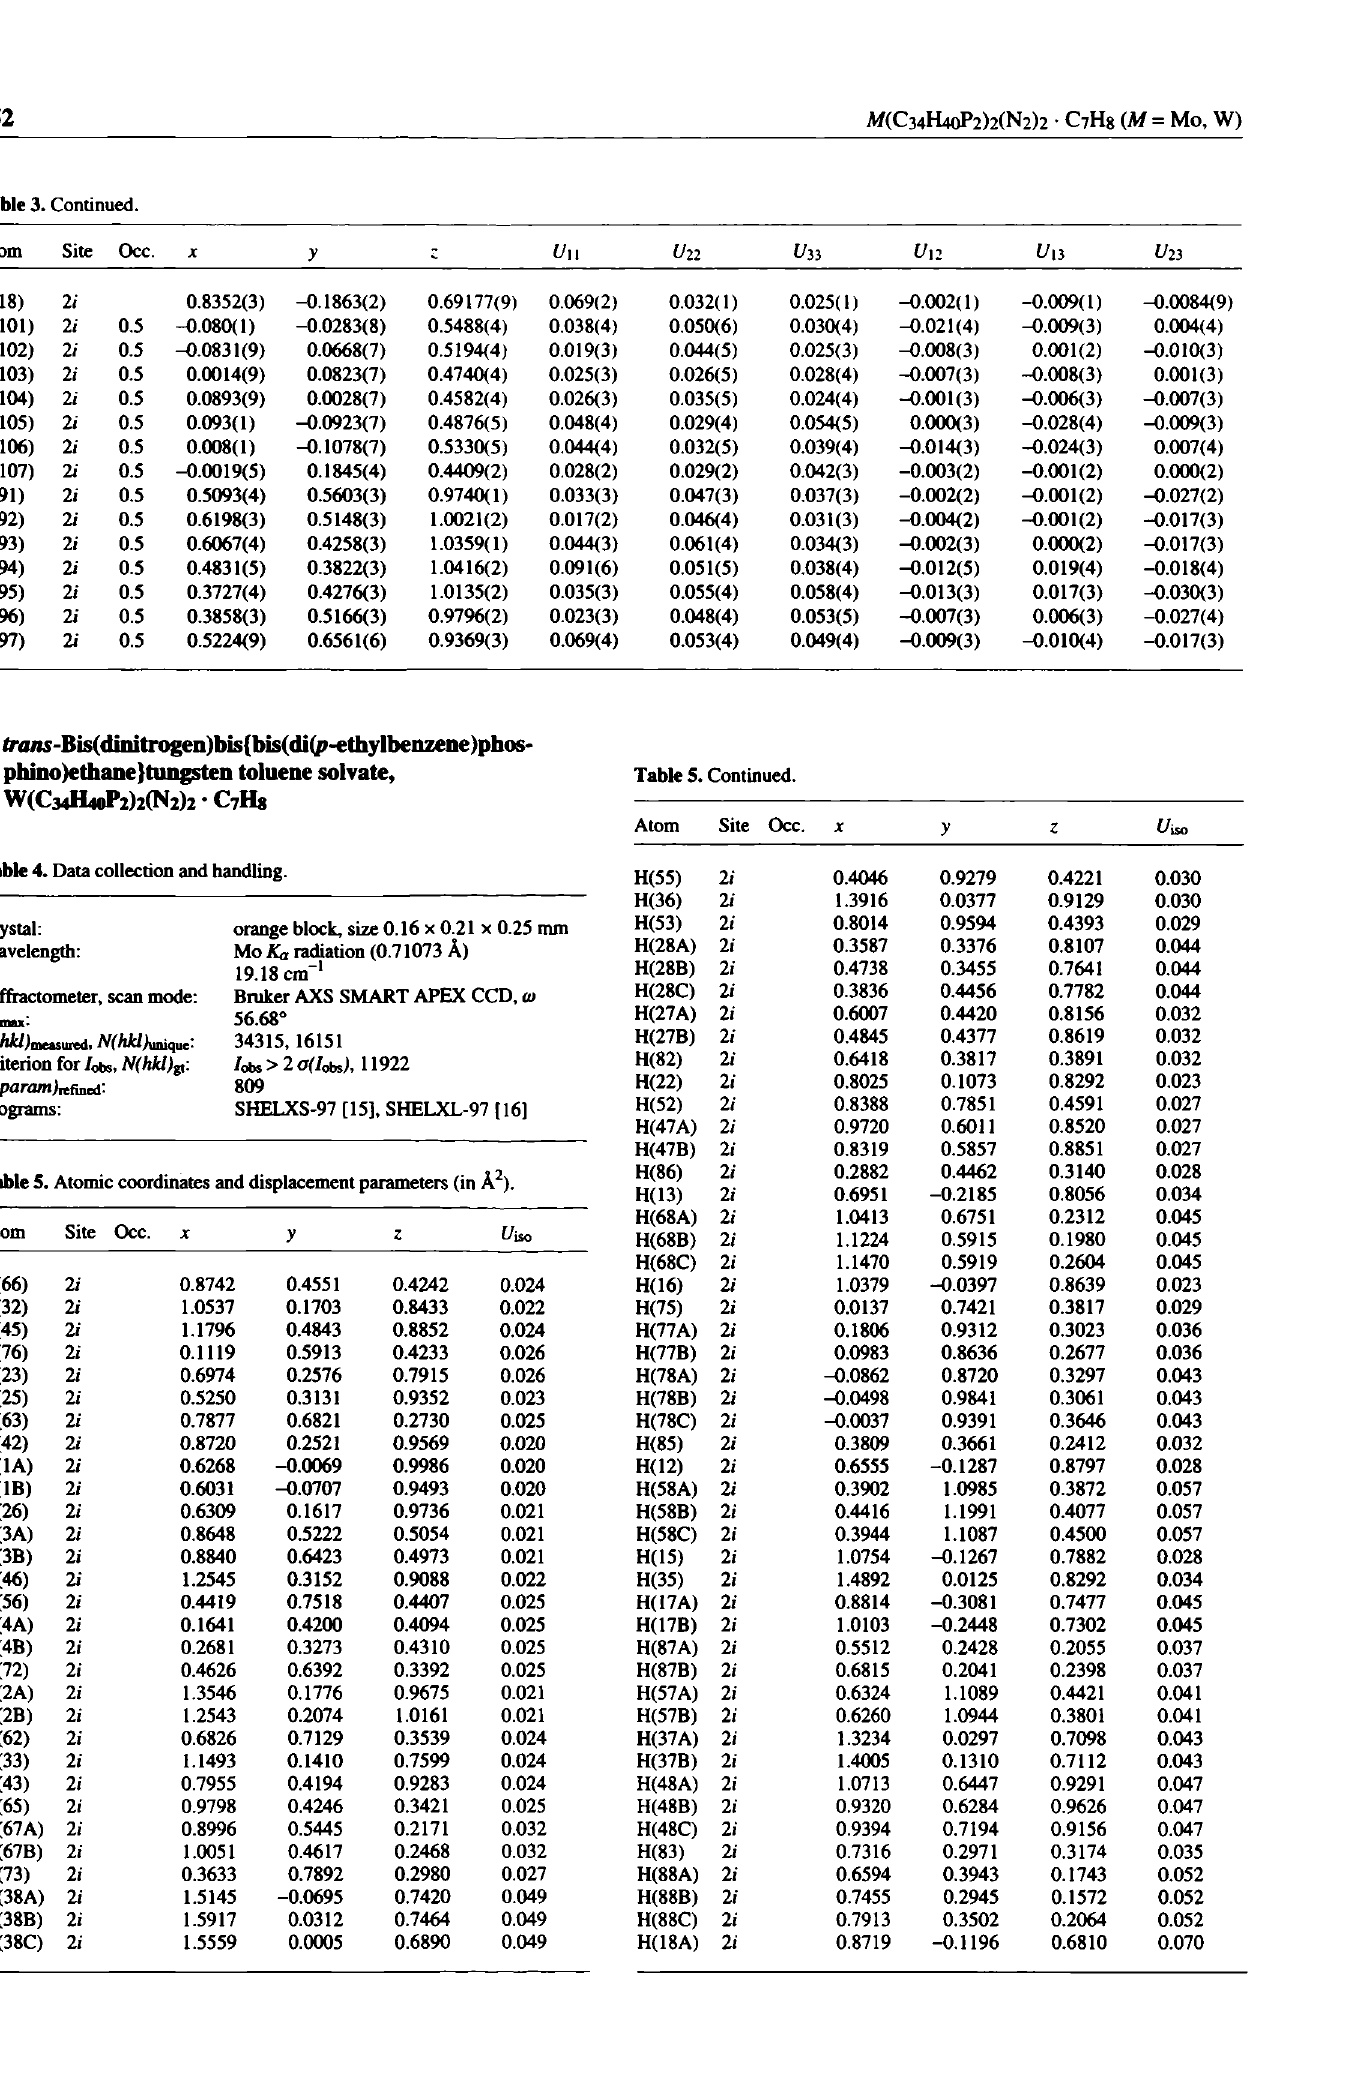
Table 4. Data collection and handling.